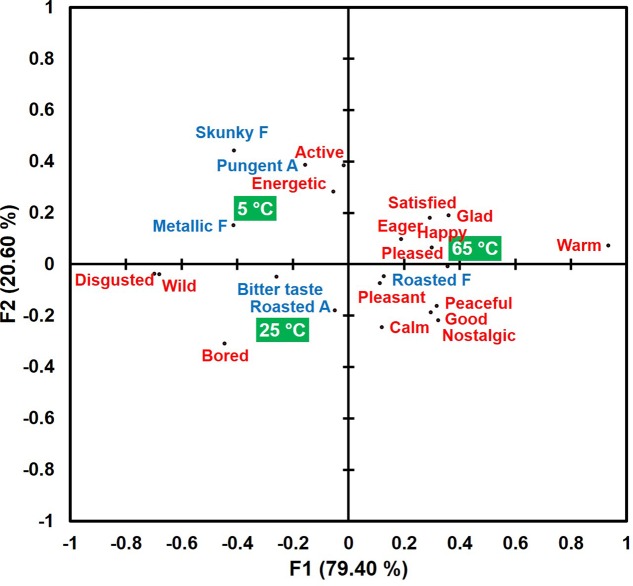
A bi-plot drawn by the correspondence analysis in the associations of sample temperatures with emotional responses (red) and sensory attributes (blue) in coffee samples evaluated at the three temperatures (green squares). “A” and “F” next to sensory attribute term represent “aroma” and “flavor,” respectively.